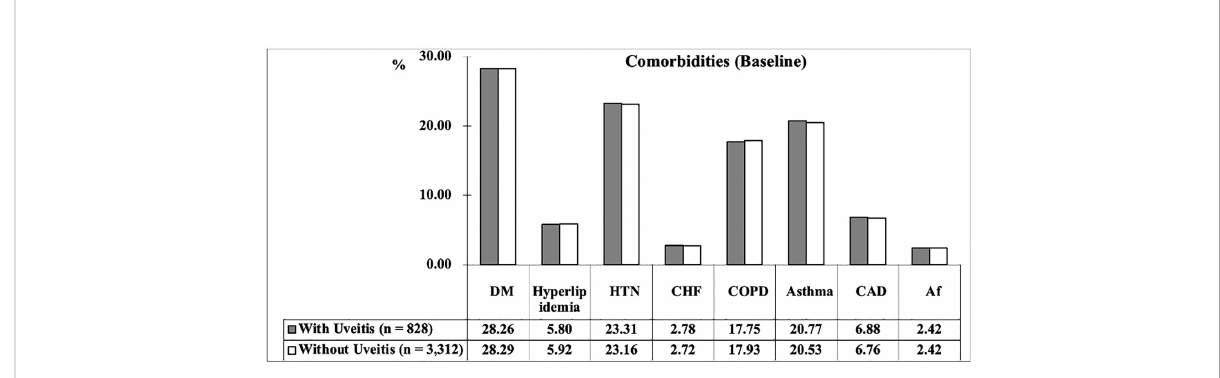
FIGURE 2 The prevalence of comorbidities between two groups at baseline.